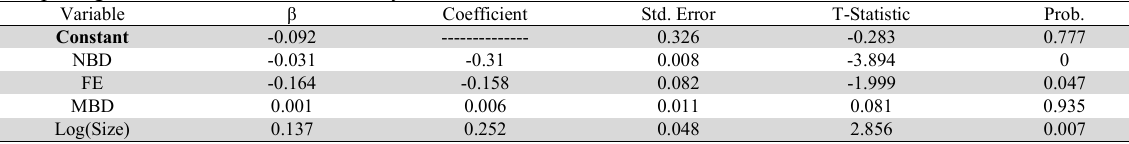
Multiple regression test results for the study model